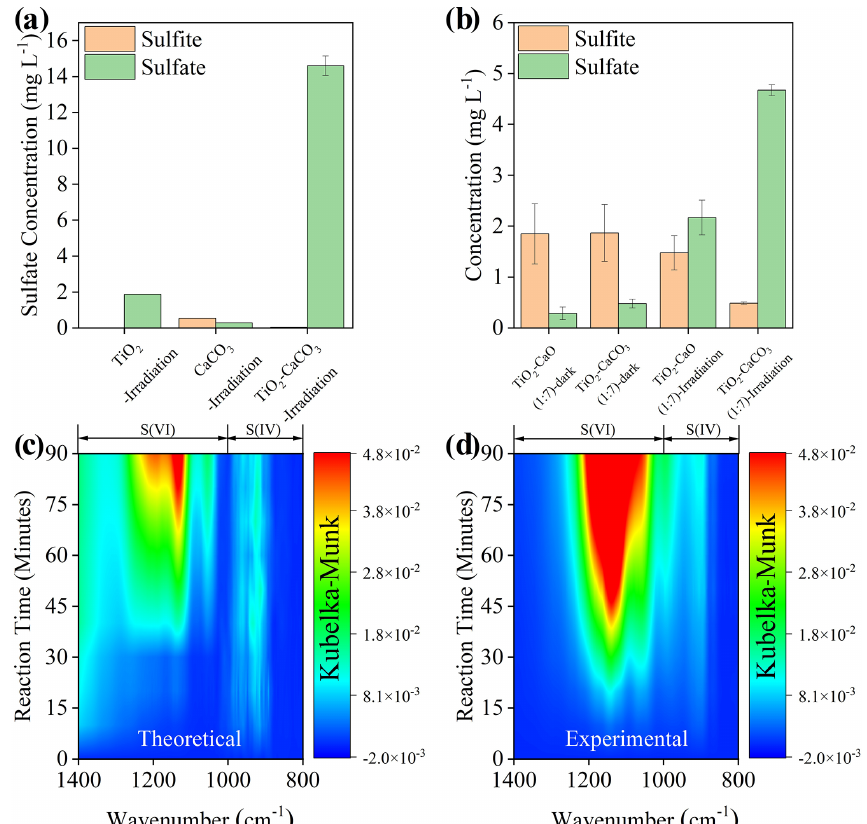
Figure 2. (a) Sulfate or sulfite concentration quantified by IC on TiO 2 , CaCO 3 , and TiO 2 + CaCO 3 particles (wt / wt = 50 / 50) after exposure to gaseous SO 2 under irradiation for 60min. (b) Sulfate and sulfite concentration quantified by IC on mineral dust particles of concern after exposure to SO 2 under dark or irradiation for 20min. In situ DRIFTS of S(IV) and S(VI) production on theoretical (c) and (d) experimental TiO 2 + CaCO 3 mixtures (wt / wt = 50 / 50) upon irradiation for 90min. All spectra were processed by the Kubelka– Munk (K–M) algorithm. Note that the production of sulfur species in theoretical TiO 2 + CaCO 3 mixtures refers to 0.5 × K–M bands of sulfur species of TiO 2 − + 0.5 × K–M bands of sulfur species of CaCO 3 , while those for experimental TiO 2 + CaCO 3 mixtures refer to 1 × K–M bands of sulfur species of TiO 2 + CaCO 3 mixtures (wt / wt = 50 / 50). Reaction conditions are RH of 30%, light intensity ( I ) of